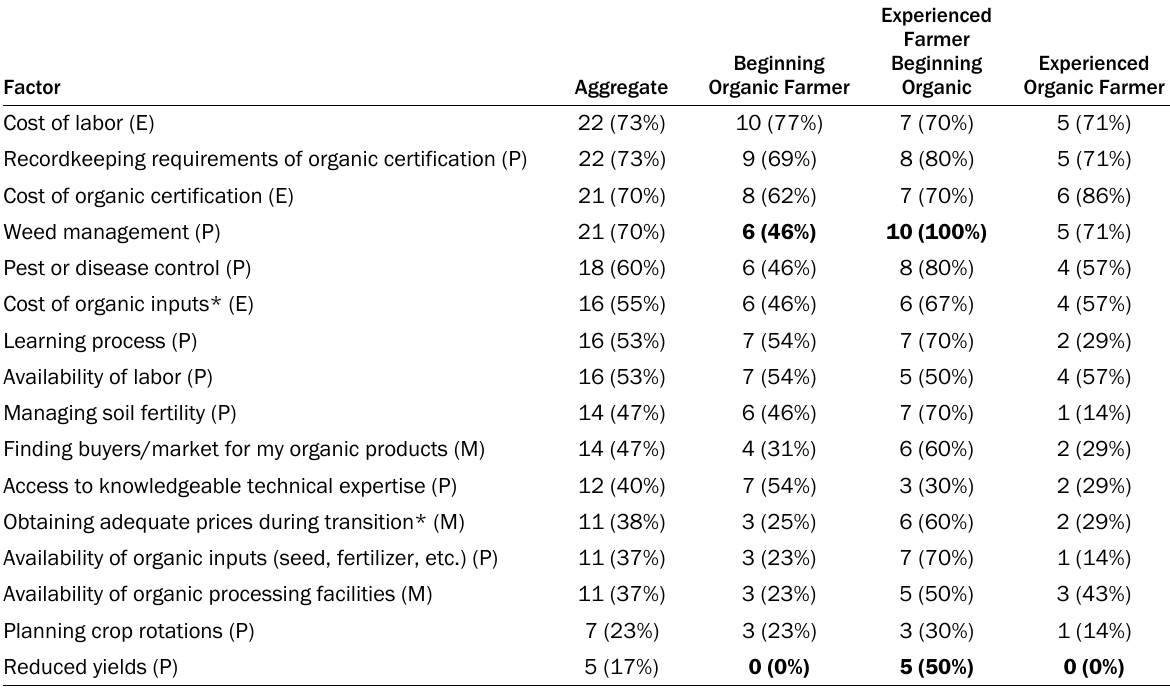
Table 7. Number of Farmers within Each Category Ranking a Factor as an